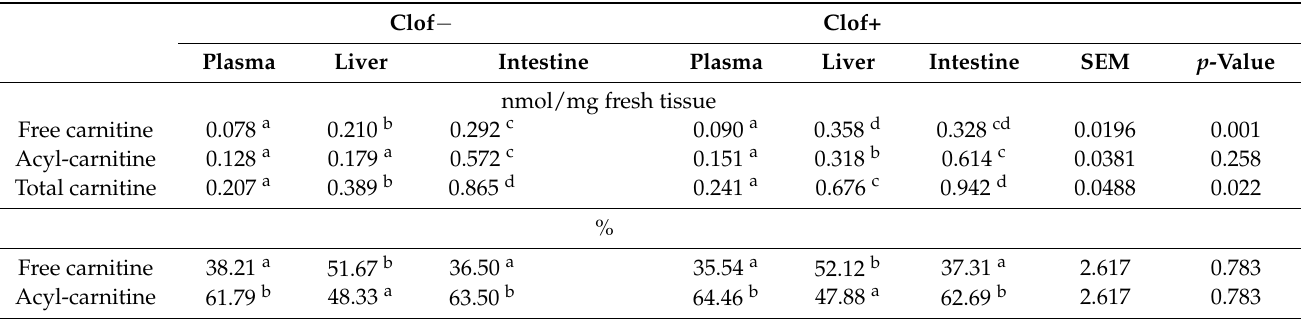
Table 4. Distribution of carnitine in plasma and